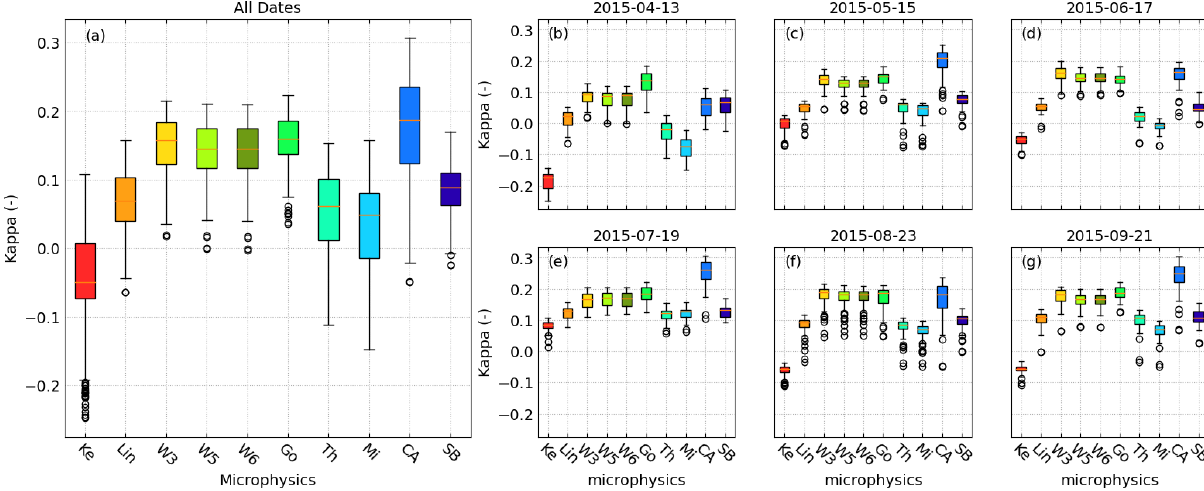
Figure 8. The box plots of κ in panel (a) show all the simulation dates and those on (b) 13 April, (c) 15 May, (d) 17 June, (e) 19 July, (f) 23 August, and (g) 21 September for Set